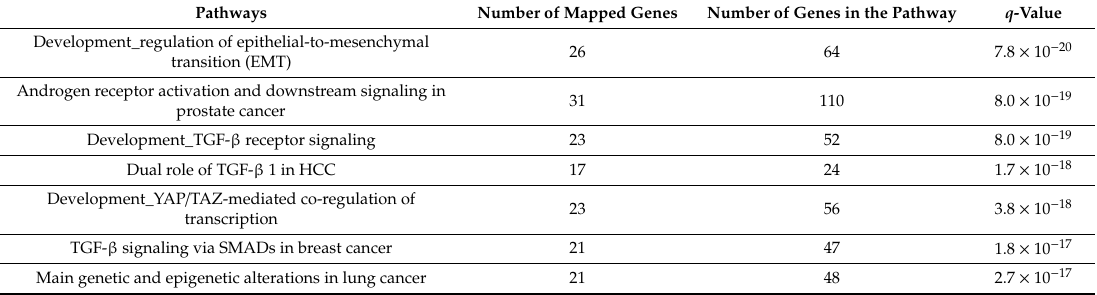
Table 3. Pathway enrichment analysis using possible target genes of the miRNA whose plasma levels showed positive correlations with CHA 2 DS 2 -VASc score. Pathways Number of Mapped Genes q